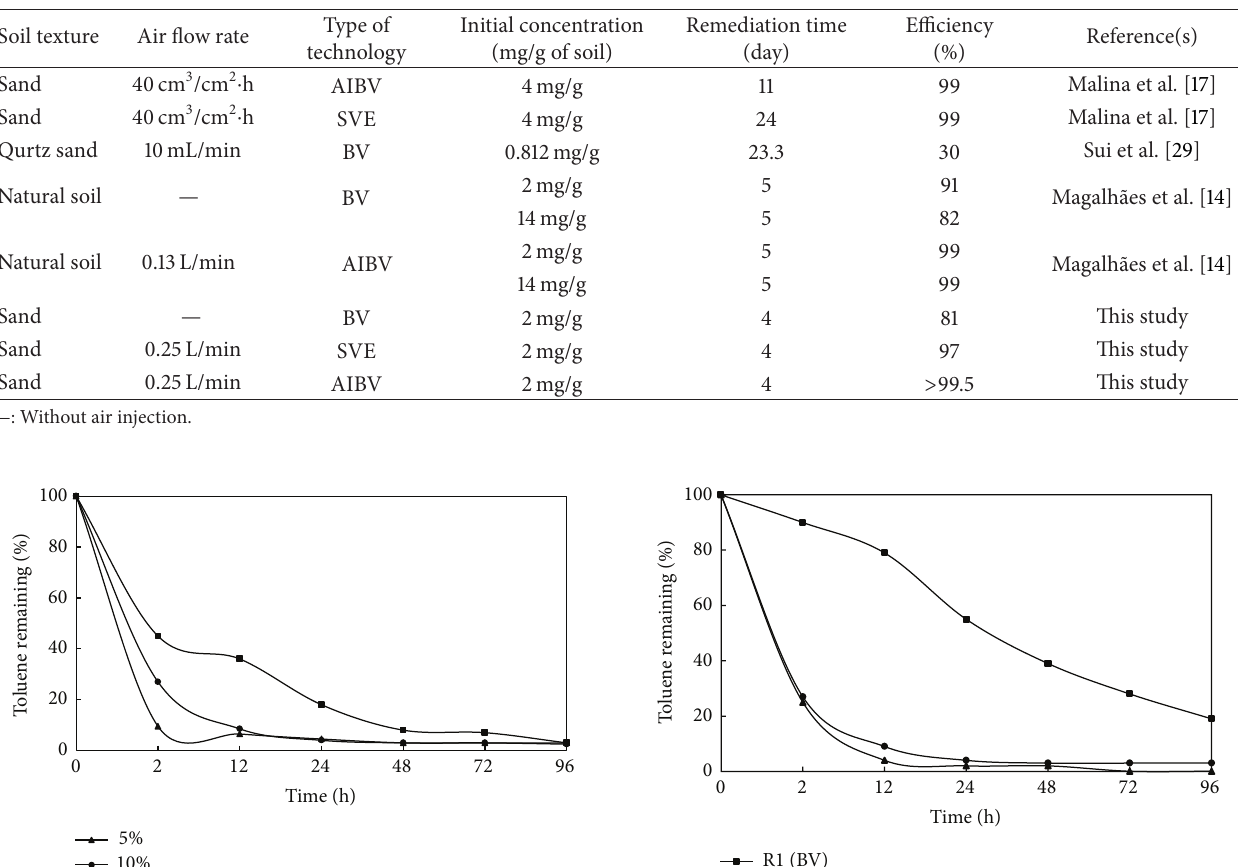
Table 2: In situ remediation tests in literature.